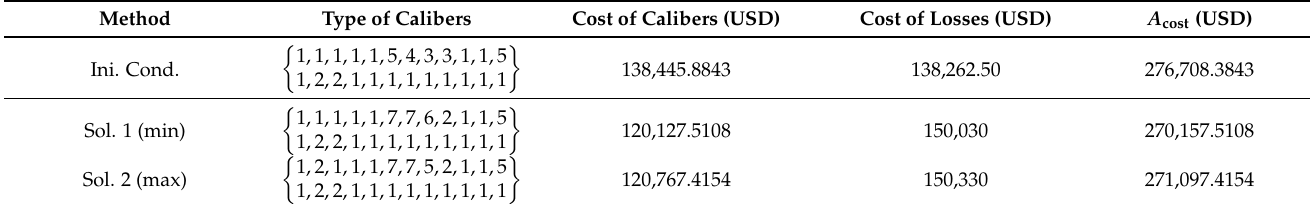
Figure 5. Selection of optimal routes for the 25-bus test feeder. Table 11. Numerical results for the 25-bus